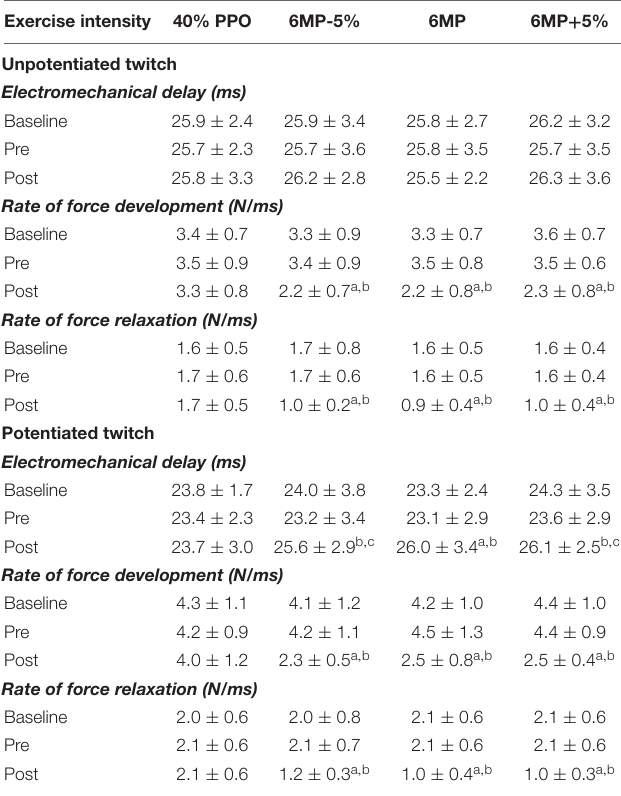
TABLE 1 | Intratwitch indexes of contractile properties during unpotentiated and potentiated twitches at baseline, before (Pre), and 30 s after (Post)